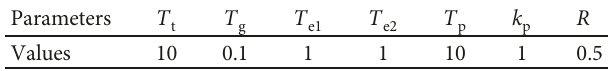
Table 1: The system parameters of the benchmark system.